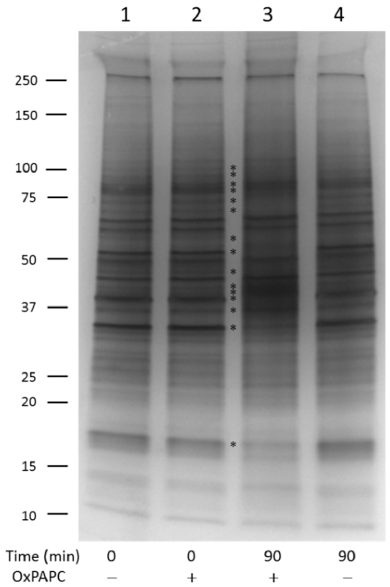
Figure 1. Gel band shift analysis of PBS-soluble human umbilical vein endothelial cell (HUVEC) proteins. Oxidized palmitoyl-arachidonoyl-phosphatidylcholine (OxPAPC) incubated with proteins for 90 min significantly changed the electrophoretic protein profile (lane 3). OxPAPC which is not covalently bound to proteins does not influence the electrophoretic mobility of proteins (lane 2). Lane 1: control sample time point 0; lane 4: control sample time point 90. The final OxPAPC concentration in treated samples was 100 µ mol/L. Main visible changes are marked with